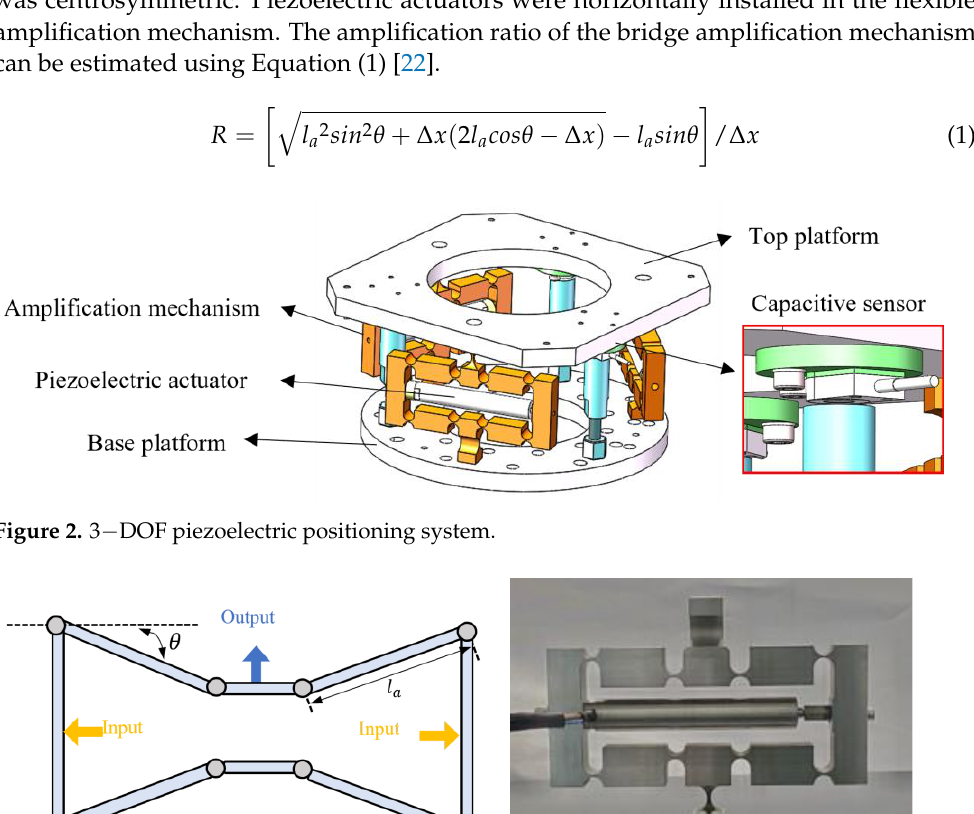
Figure 2. 3 − DOF piezoelectric positioning system.